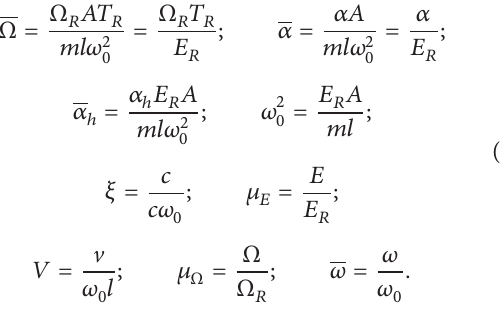
and 𝜀 = 𝑢/𝑙 . In order to obtain a dimensionless equation of motion, the system’s parameters are defined as